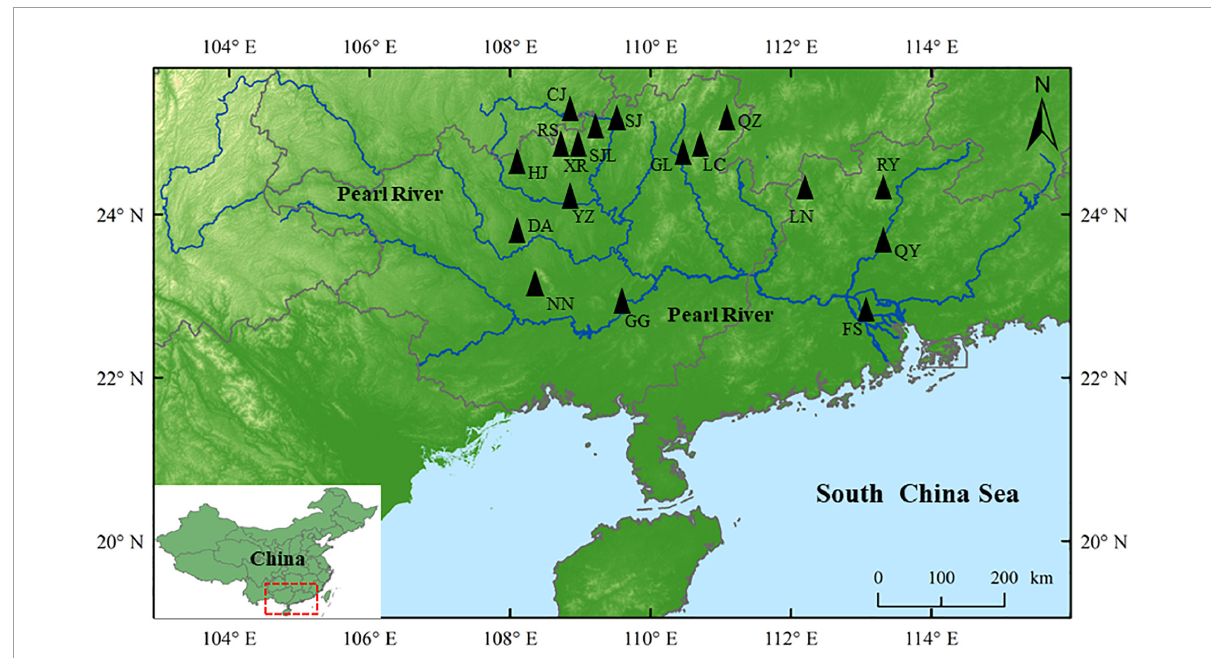
FIGURE1 Map of sample sites of PF-carp specimens. Geographical distribution details and the number of samples collected per site are provided in Supplementary Table 1 . CJ, Congjiang; DA, Du’an; FS, Foshan; GG, Guigang; GL, Guilin; HJ, Huanjiang; LC, Linchuan; LN, Liannan; NN,